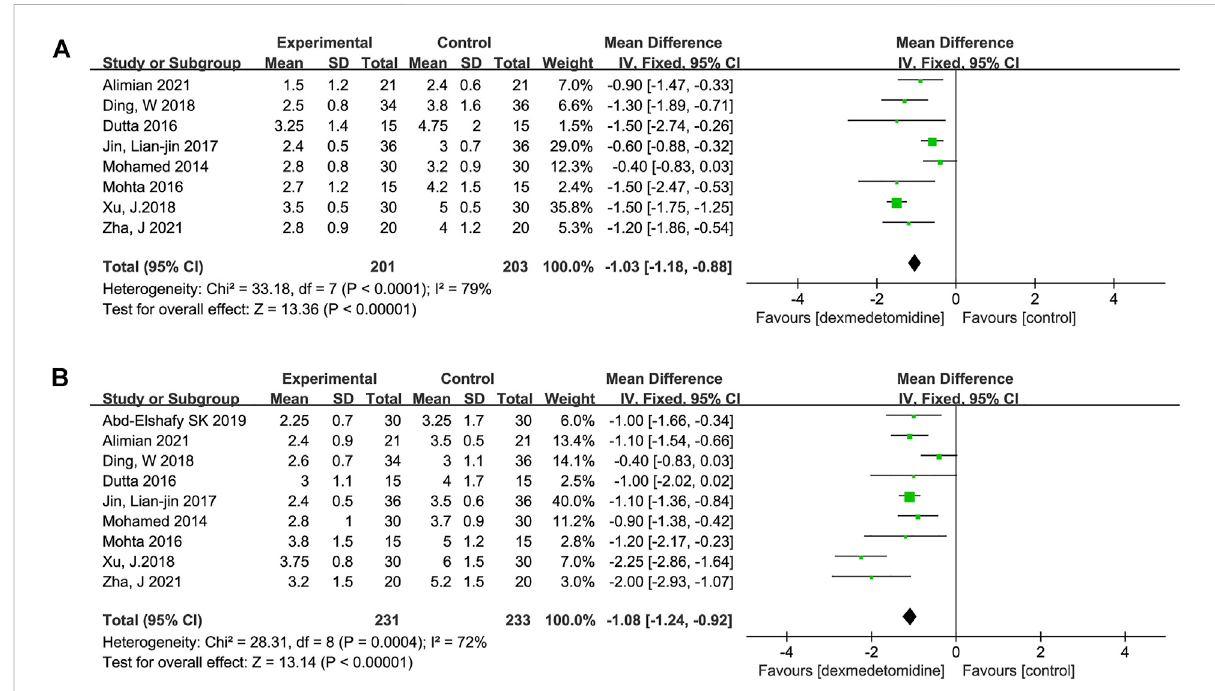
Table 3. Dexmedetomidine combined with LA reduced oral morphine equivalent consumption by an MD (95%